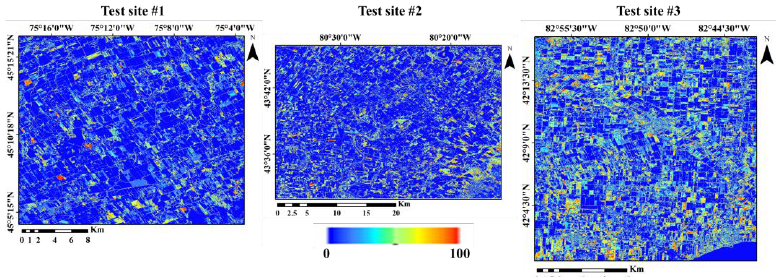
Figure 5. Uncertainty of land crop/cover map obtained from voting strategy for test sites 1, 2, and 3. It is ranged between 0 and 100. The blue color is related to 0 and red color is related to 100. The mean uncertainty for the classification of different land crops was different (Figure 6). Mean uncertainty for urban/ developed, exposed land/barren, water, shrubland, soybeans, pasture/forages, winter wheat, corn, spring wheat, and follow classes were 19.6, 20.7, 7.7, 12.1, 13.5, 16.5, 15.7, 12.2, 27.5, and 14.9%, respectively. The results showed that spring wheat had the most uncertainty, and water the least, compared to others.